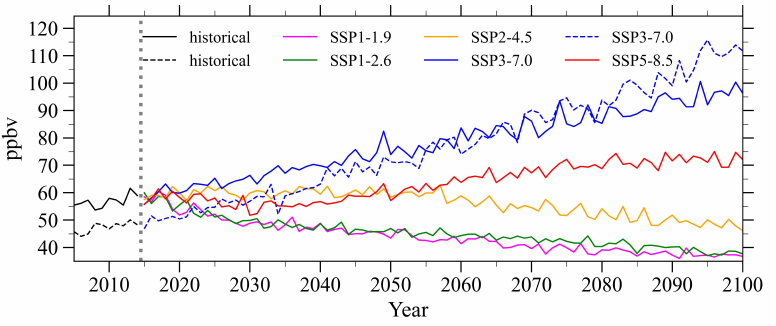
Figure 9. Time series of JJA mean CO mixing ratio (ppbv) within the ASM region (0 ◦ –60 ◦ N, 0 ◦ –150 ◦ E) at 100 hPa under different scenarios. Solid lines indicate results from GFDL-ESM4 and dashed lines are results from